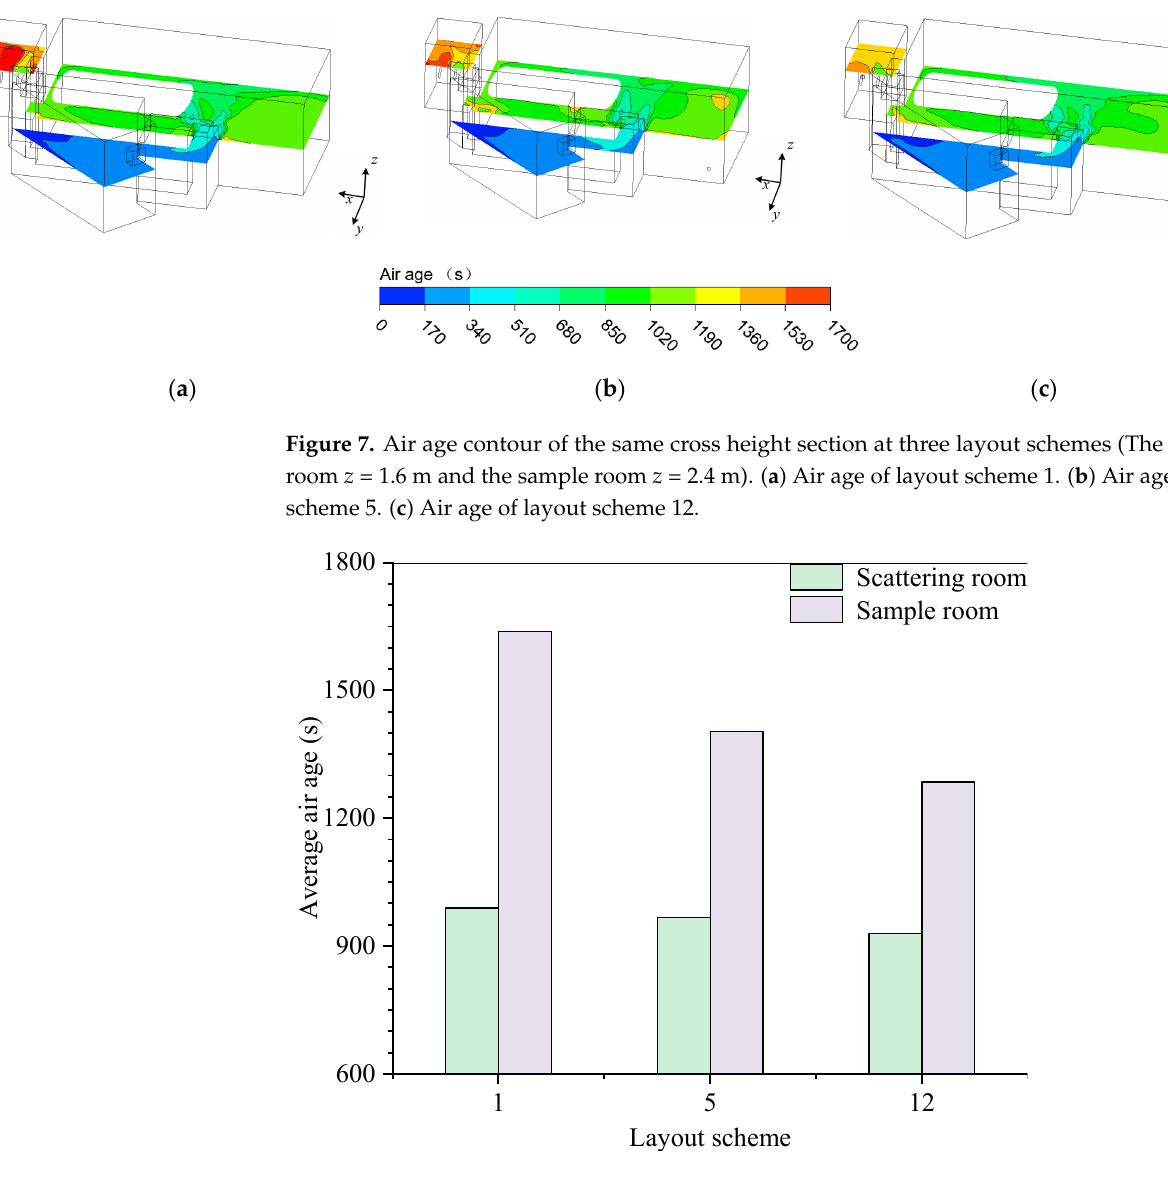
Figure 8. Comparison of average air age of three layout schemes (The scattering room z = 1.6 m and the sample room z = 2.4 m).